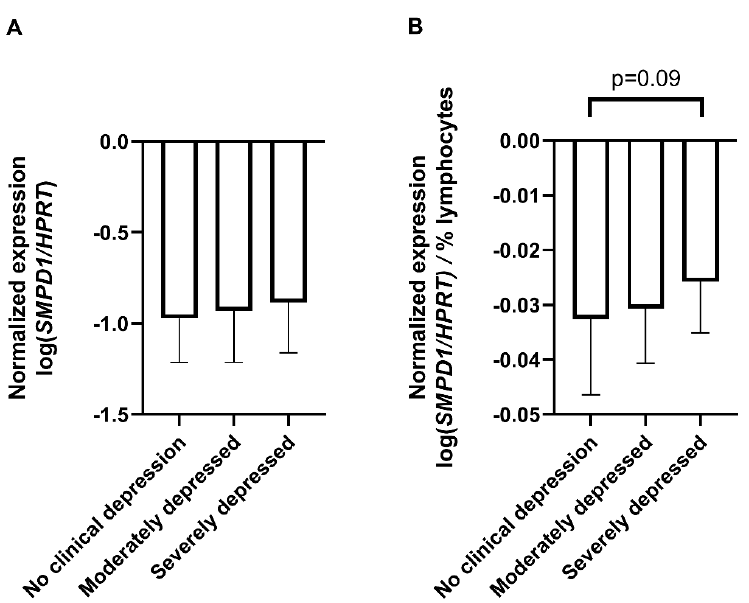
Figure 3. SMPD1 mRNA expression in blood cells of unmedicated depressed patients and healthy controls. ( A ) No differences between depressed patients and healthy controls. SMPD1 mRNA expression did not differ between healthy and moderately or severely depressed patients; ( B ) Impact of lymphocyte percentage on SMPD1 expression differences between depressed patients and healthy controls. When taking the lymphocyte percentage into account, there was a trend in our sample towards an increase in SMPD1 mRNA expression in severely, but not moderately depressed patients as compared with individuals without clinical depression. Data represent the mean and SD.